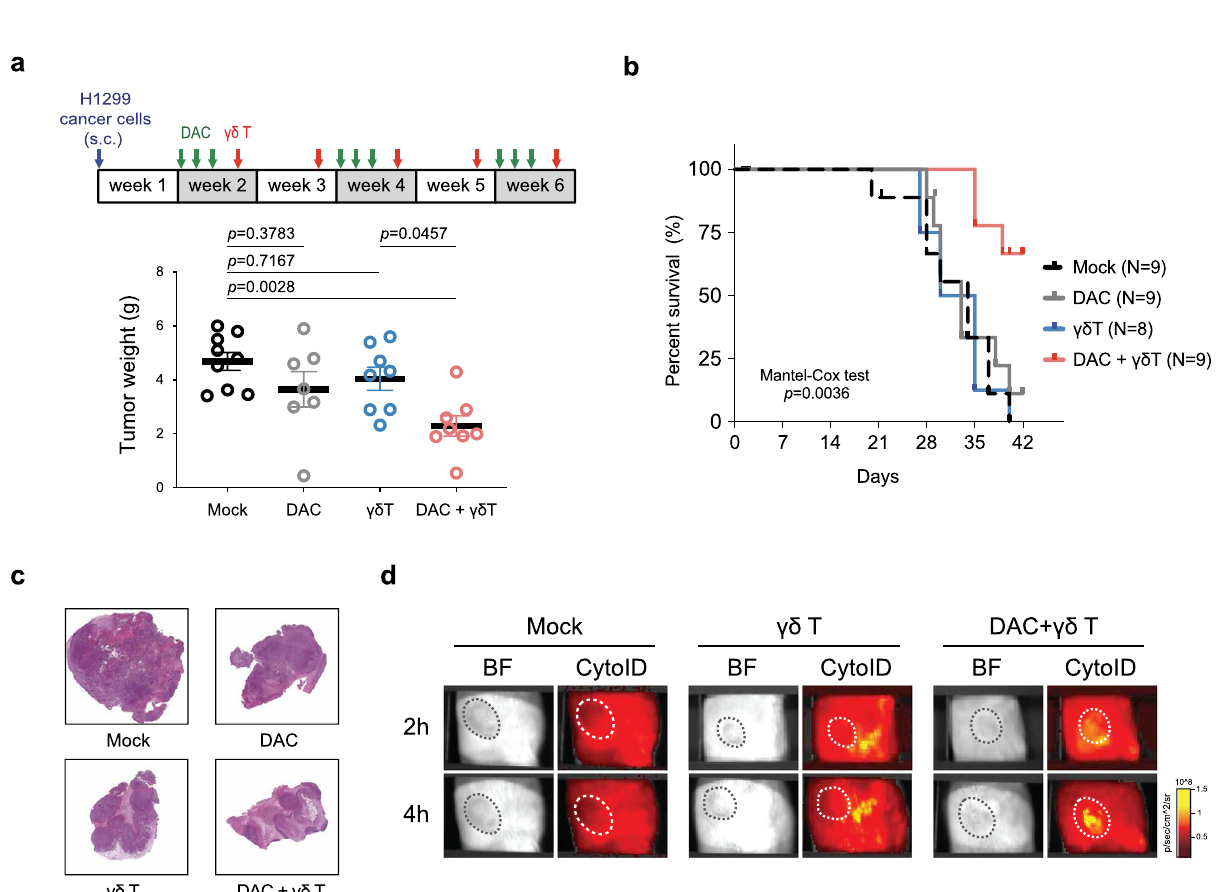
Fig. 5 Depletion of DNMTs induces γδ T-sensitive cytoskeletal gene expression in cancer cells. a A volcano plot showing differentially expressed genes in DAC-treated vs. Mock-treated human lung cancer cells (i.e., A549, CL1-0, CL1-5, PC9, and H1299). The y-axis denotes statistical signi fi cance ( − log10 of p -value), and the x -axis displays the log2 fold change values between the DAC-treated and the Mock-treated groups. Genes related to the actin cytoskeleton, intermediate fi laments, microtubule are marked in red, blue, and green, respectively. b Gene Set Enrichment Analysis (GSEA) of mRNA-seq data in fi ve DAC-treated lung cancer cell lines — A549, CL1-0, CL1-5, PC9, and H1299. Gene sets related to actin-cytoskeleton reorganization, intermediate fi lament-based process, and microtubule-related gene modules are shown. NES Normalized Enrichment Score, GO gene ontology. c Heatmap showing mRNA expression of core enrichment genes for actin-cytoskeleton, intermediate fi lament, and microtubule-related processes in DAC-treated and mock- treated human lung cancer cells measured by mRNA-seq. FPKM fragments per kilobase of transcript per million mapped reads. d Gene Set Enrichment Analysis (GSEA) of mRNA-seq data in HCT116 and DLD1 human colorectal cancer cell lines subject to shRNA knockdown of DNA methyltransferase 1 (DNMT1). Gene sets related to actin-cytoskeleton reorganization, intermediate fi lament-based process, and microtubule-related gene modules are shown. NES Normalized Enrichment Score. e Box plots showing promoter methylation status of genes in the actin cytoskeleton-, intermediate fi lament-, and microtubule-related gene modules in human lung cancer cells treated with 100 nM DAC for three days followed by a 3-day drug-free culture (D3R3). The box denotes the 25th percentile, the median, and the 75th percentile. The whiskers indicate minimum and maximum values. Methylation data are analyzed by In fi nium MethylationEPIC arrays. n = 1 for each treatment of individual cell lines. M mock-treated, D DAC-treated. f Relative chromatin accessibility around TSS of genes ( − 3 to + 3 kb) in the actin-cytoskeleton reorganization, intermediate fi lament-based process, and microtubule-related modules in DAC-treated vs. mock-treated lung cancer cell lines. TSS transcription start site.